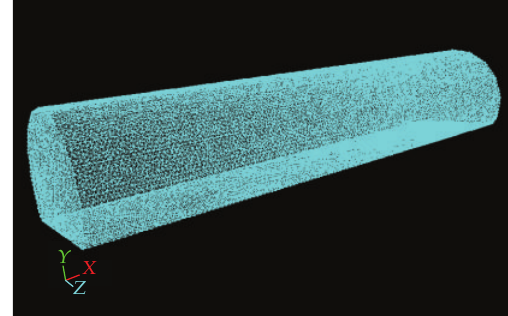
Figure 3: Model 3: geometry and mesh.